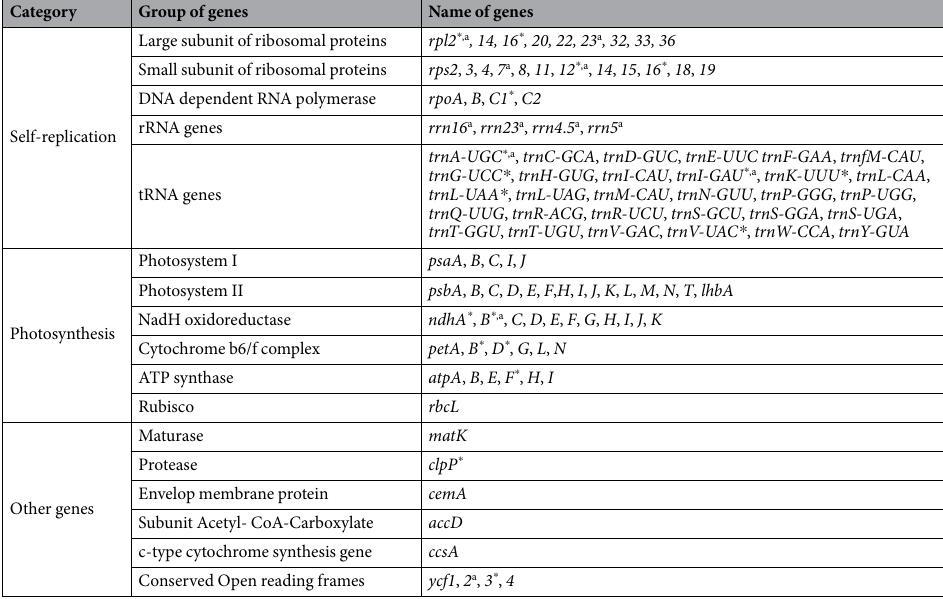
Table 2. List of genes in the A . halleri ssp. gemmifera and A . lyrata ssp. petraea chloroplast genomes. * Genes containing introns; a Duplicated gene (Genes present in the IR